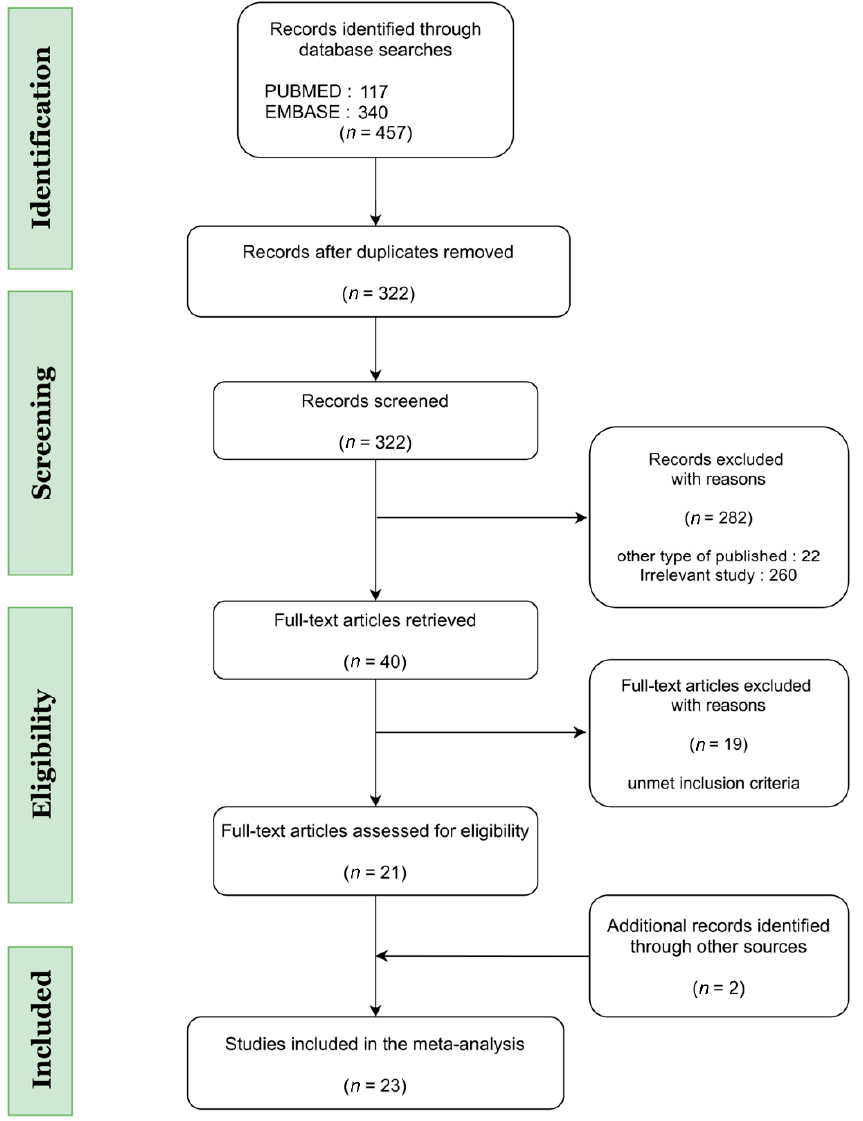
Figure 1. Flowchart of study identification and